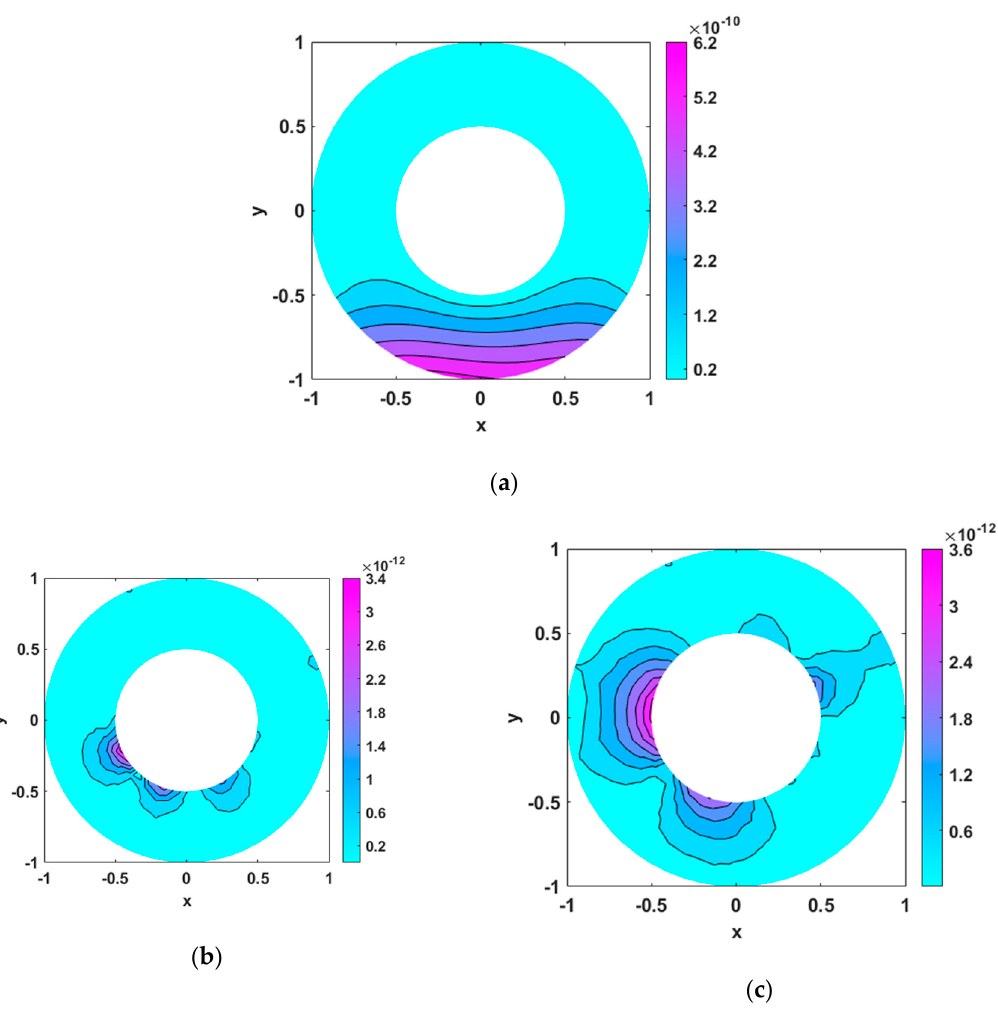
Figure 8. Contour plots of absolute errors (%): ( a ) half unknown outer boundary; ( b ) half unknown inner boundary; ( c ) unknown inner boundary.